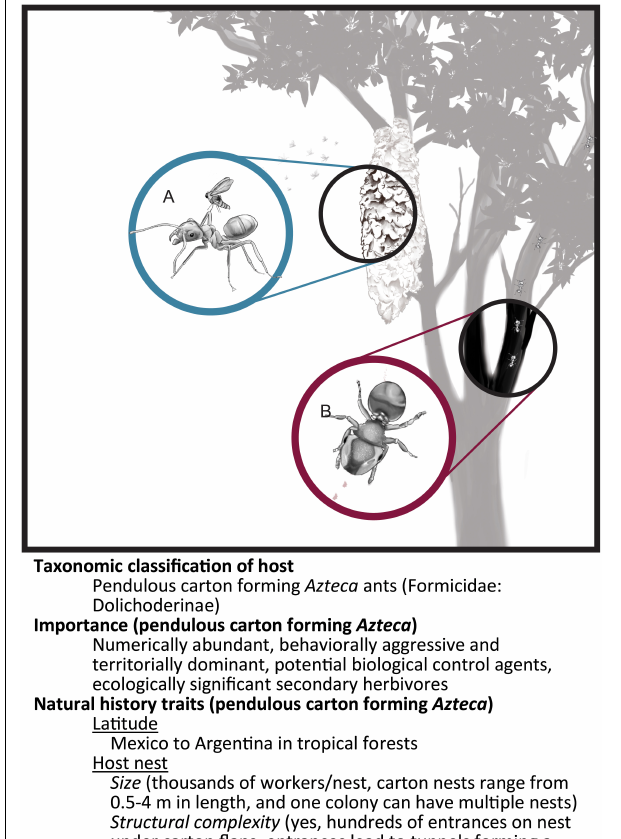
( Figure 1D , top panel). Finally, the developing phorid larva may manipulate the behavior of the host ant until development of the parasitoid is complete (often culminating in decapitation of the host; Figure 1E , top panel) (reviewed in Henne and Johnson, 2007; de Bekker et al., 2018). Stages leading to successful exploitation have been studied in various systems where colony size is large and ant nests are permanent (see case studies of Atta Box 1 and Azteca Box 2 ) but also in species where workers forage individually (e.g., Paraponera ) or in large groups (e.g., army ants). Due to their high diversity, the phorid flies are an informative research model for understanding host specificity, and the ecology and evolution of eavesdropping of ant chemical